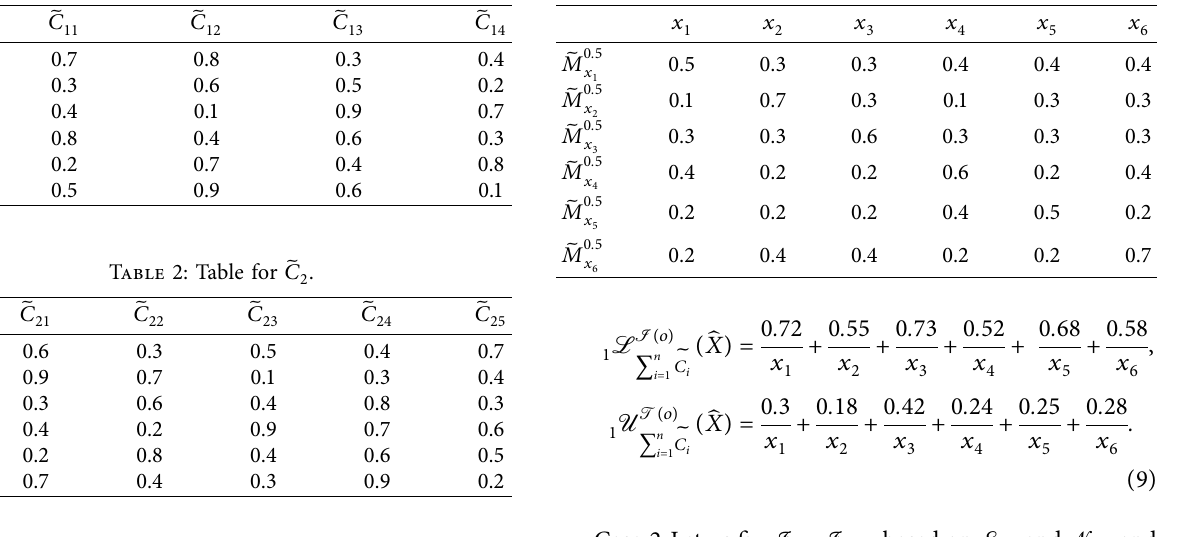
Table 1: Table for 􏽥 C